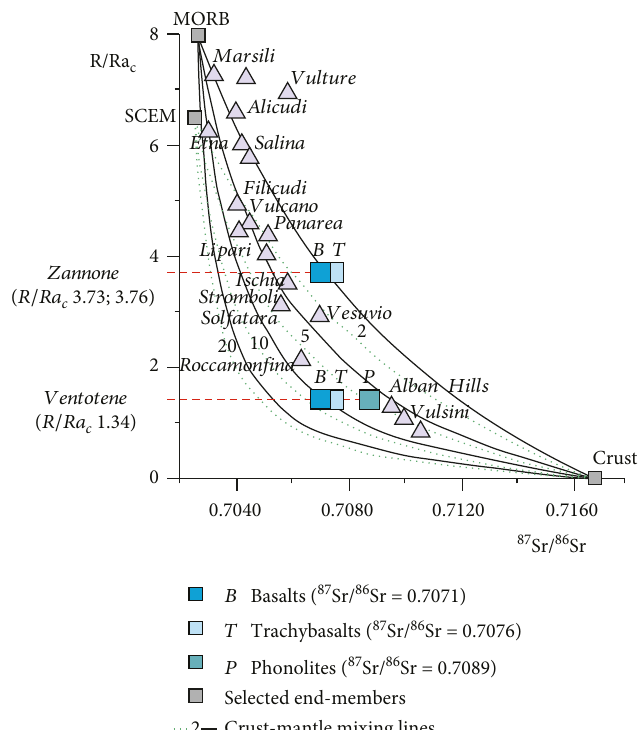
Figure 7: 87 Sr/ 86 Sr versus R/Ra for solid and gas samples from the Tyrrhenian area (modi fi ed after Martorelli et al. [27]). The lines are binary c mixing between MORB-type mantle and SCEM-type mantle (Subcontinental European Mantle; Dunai and Baur [70]) with a crustal end- member. Numbers (2, 5, 10, and 20) indicate the k value ( k = He/Sr / He/Sr ) for each curve. Assumed values for mantle and crust mantle crust end-members: 3 He/ 4 He = 0 01Ra [77]; 3 He/ 4 He = 8Ra [78]; 3 He/ 4 He = 6 5Ra [70]; 87 Sr/ 86 Sr = 0 720 [79]; radiogenic MORB SCEM radiogenic and 87 Sr/ 86 Sr = 0 7030 [80]. He = 5 × 10 − 5 cm 3 STP/g [81]; He = 5 × 10 − 7 cm 3 STP/g [78]; Sr = 333 ppm [82]; asthenosphere contcrust HIMU contcrust and Sr = 16 4 ppm [83]. Data after D'Antonio et al. [71], Barberi et al. [72], Martelli et al. [68], and Italiano et al. MORB